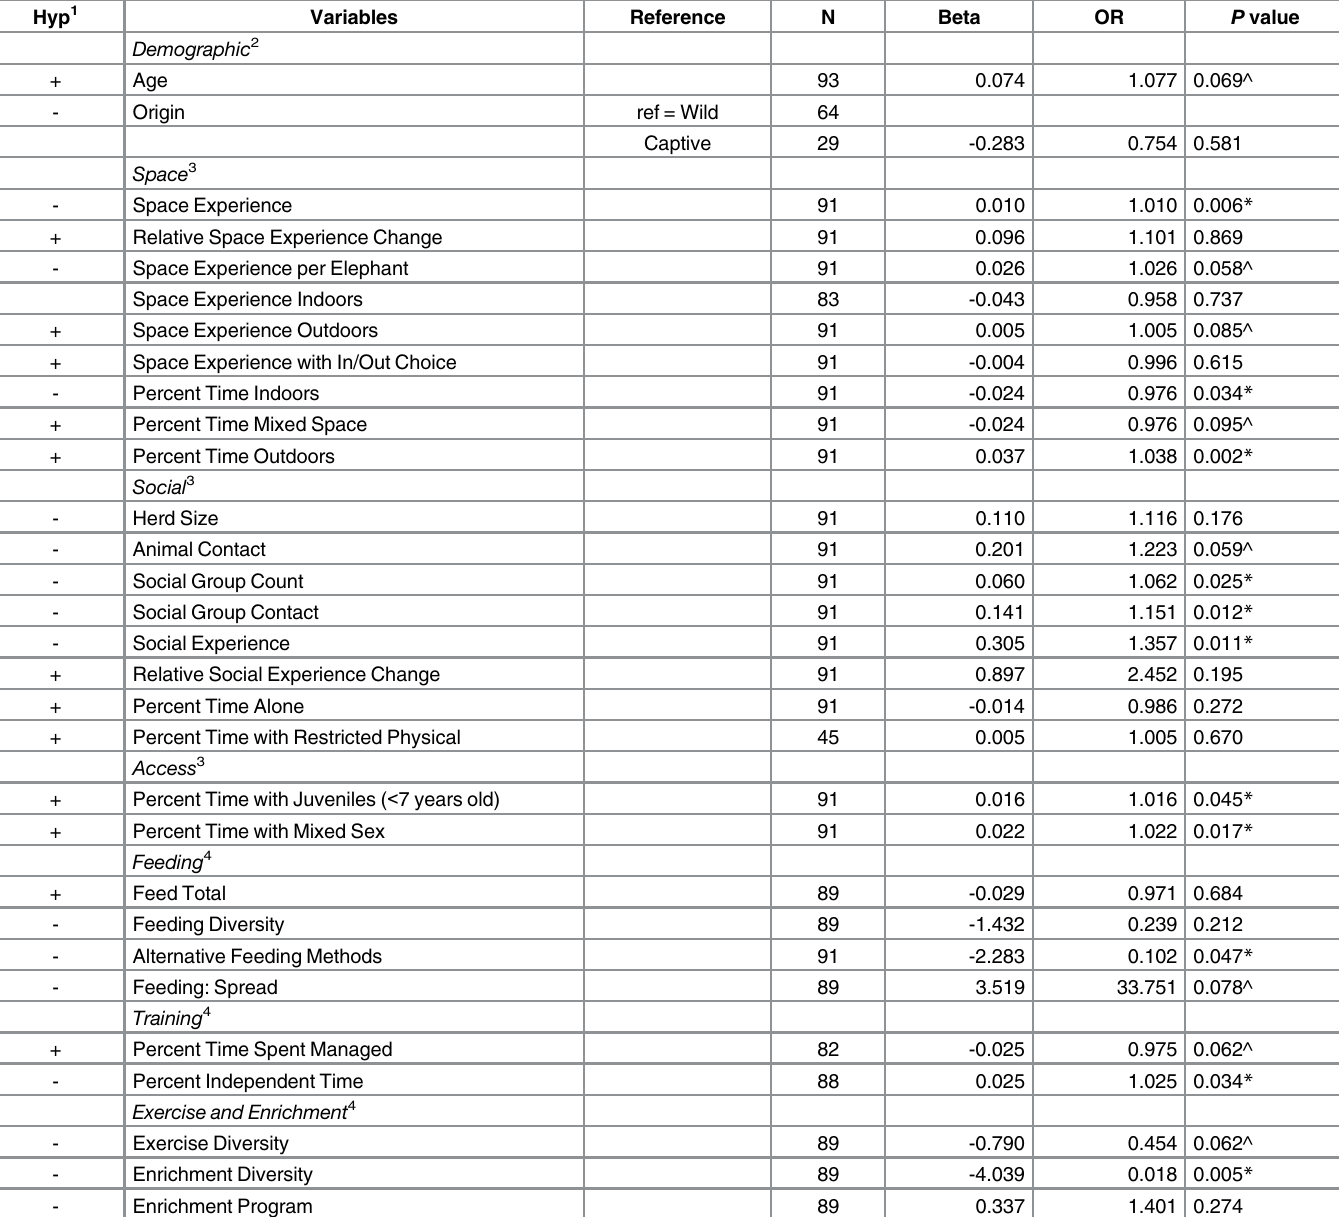
Table 9. Univariate assessment of hyperprolactinemia in African female elephants using logistic regression. OR: Odds